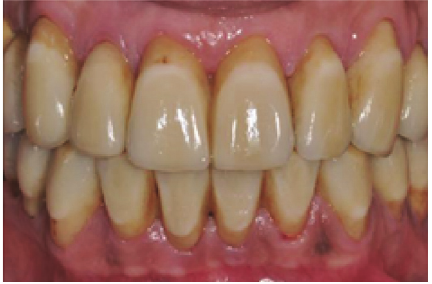
Figure 22: Frontal view.